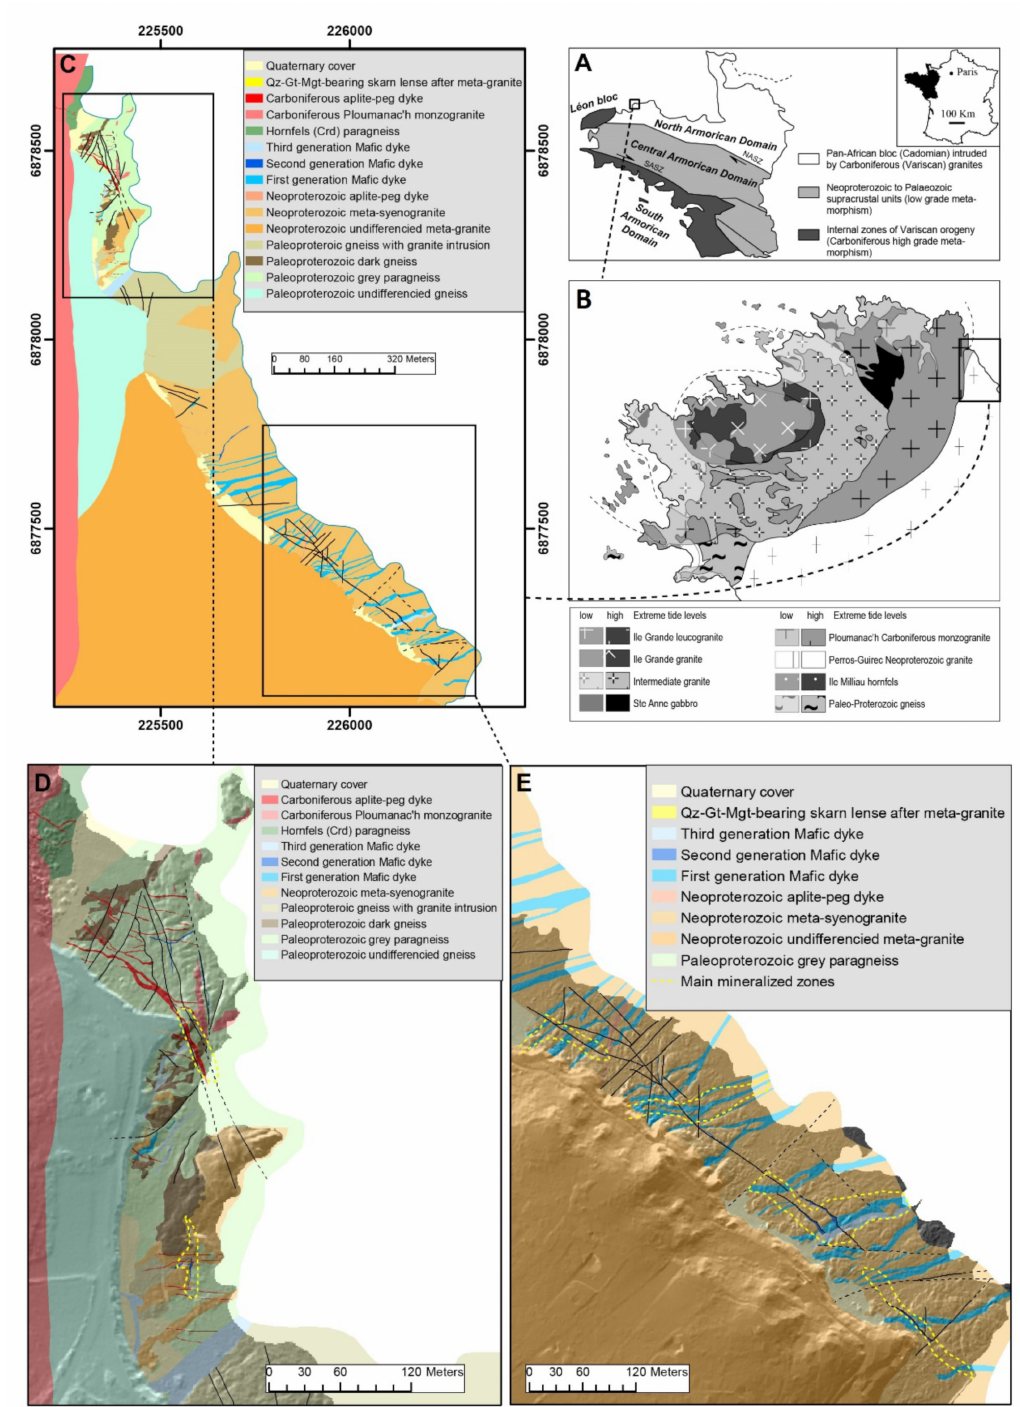
Figure 2. Geological map and location of the study area. ( A ) Sketch map of the Armorican massif displaying the main geological domains and the location of the study area. ( B ) Simplified geological map of the Ploumanac’h igneous complex, modified from [21]; the study area is located on the eastern border of the complex. ( C ) Geological map of the working area (this study). ( D ) Detailed geological map of the Ranolien sector displaying the contact between the Paleo-Proterozoic host, the Neoproterozoic Perros-Guirec granite and the Ploumanac’h Carboniferous granite. Pegmatites and aplite dykes (in red) derived from Ploumanac’h pluton crosscut all the previous lithologies. Sun-shading using 1 m × 1 m resolution RGE ALTI Digital Terrain Model from IGN. ( E ) Detailed geological map of the Trestraou sector showing the high density of mafic dykes crosscutting the Perros-Guirec Neoproterozoic granite. Note that numerous dykes are crosscut by NW-SE faults. Main mineralized zones along NW-SE faults and along mafic dyke contacts are highlighted by yellow-dashed